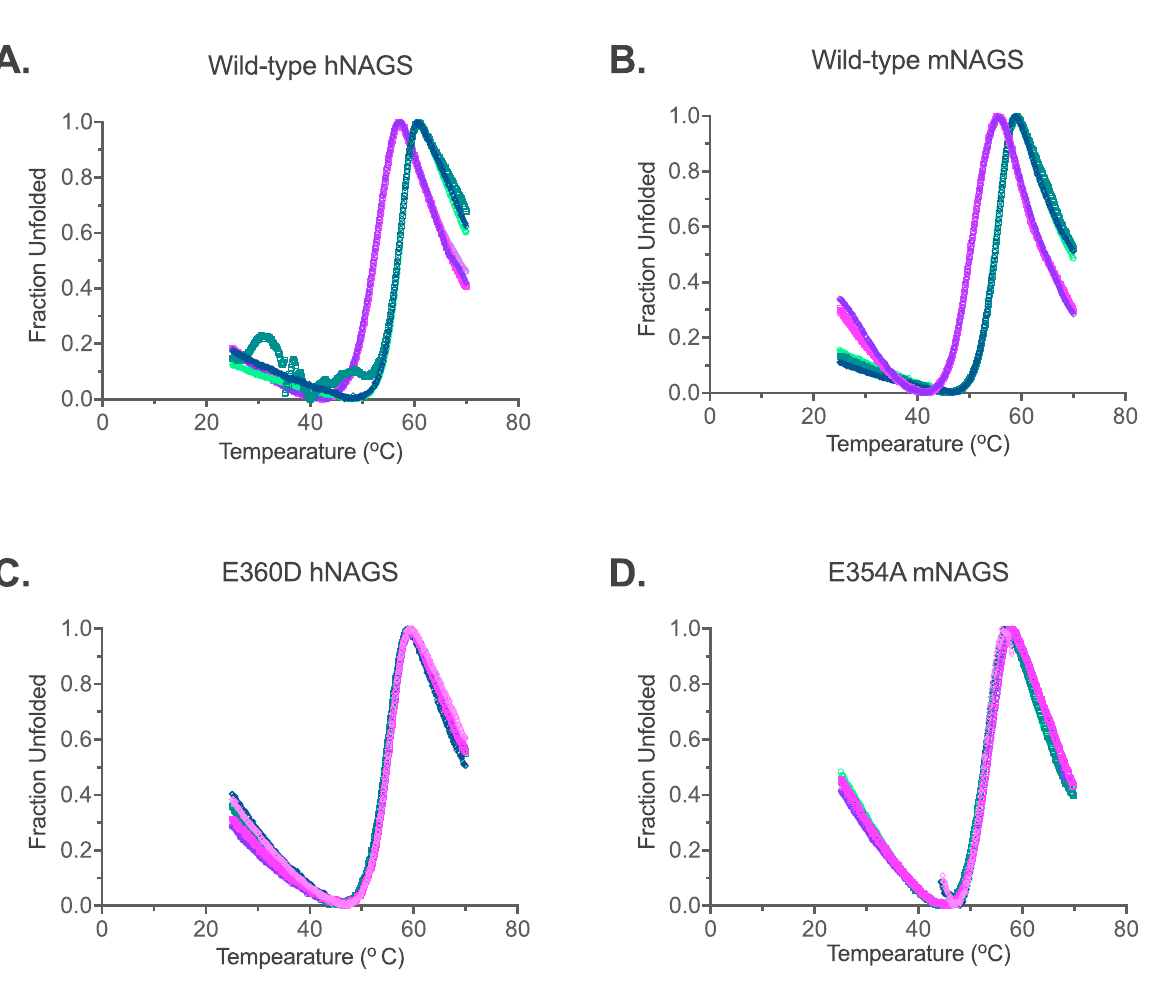
Figure 9. Thermal stability of wild-type human ( A ) and mouse ( B ) NAGS, E360D human NAGS ( C ), and E354D mouse NAGS ( D ) in the presence of either L-arginine (purple) or D-arginine (teal). Different shades of purple and teal represent technical replicates of thermal